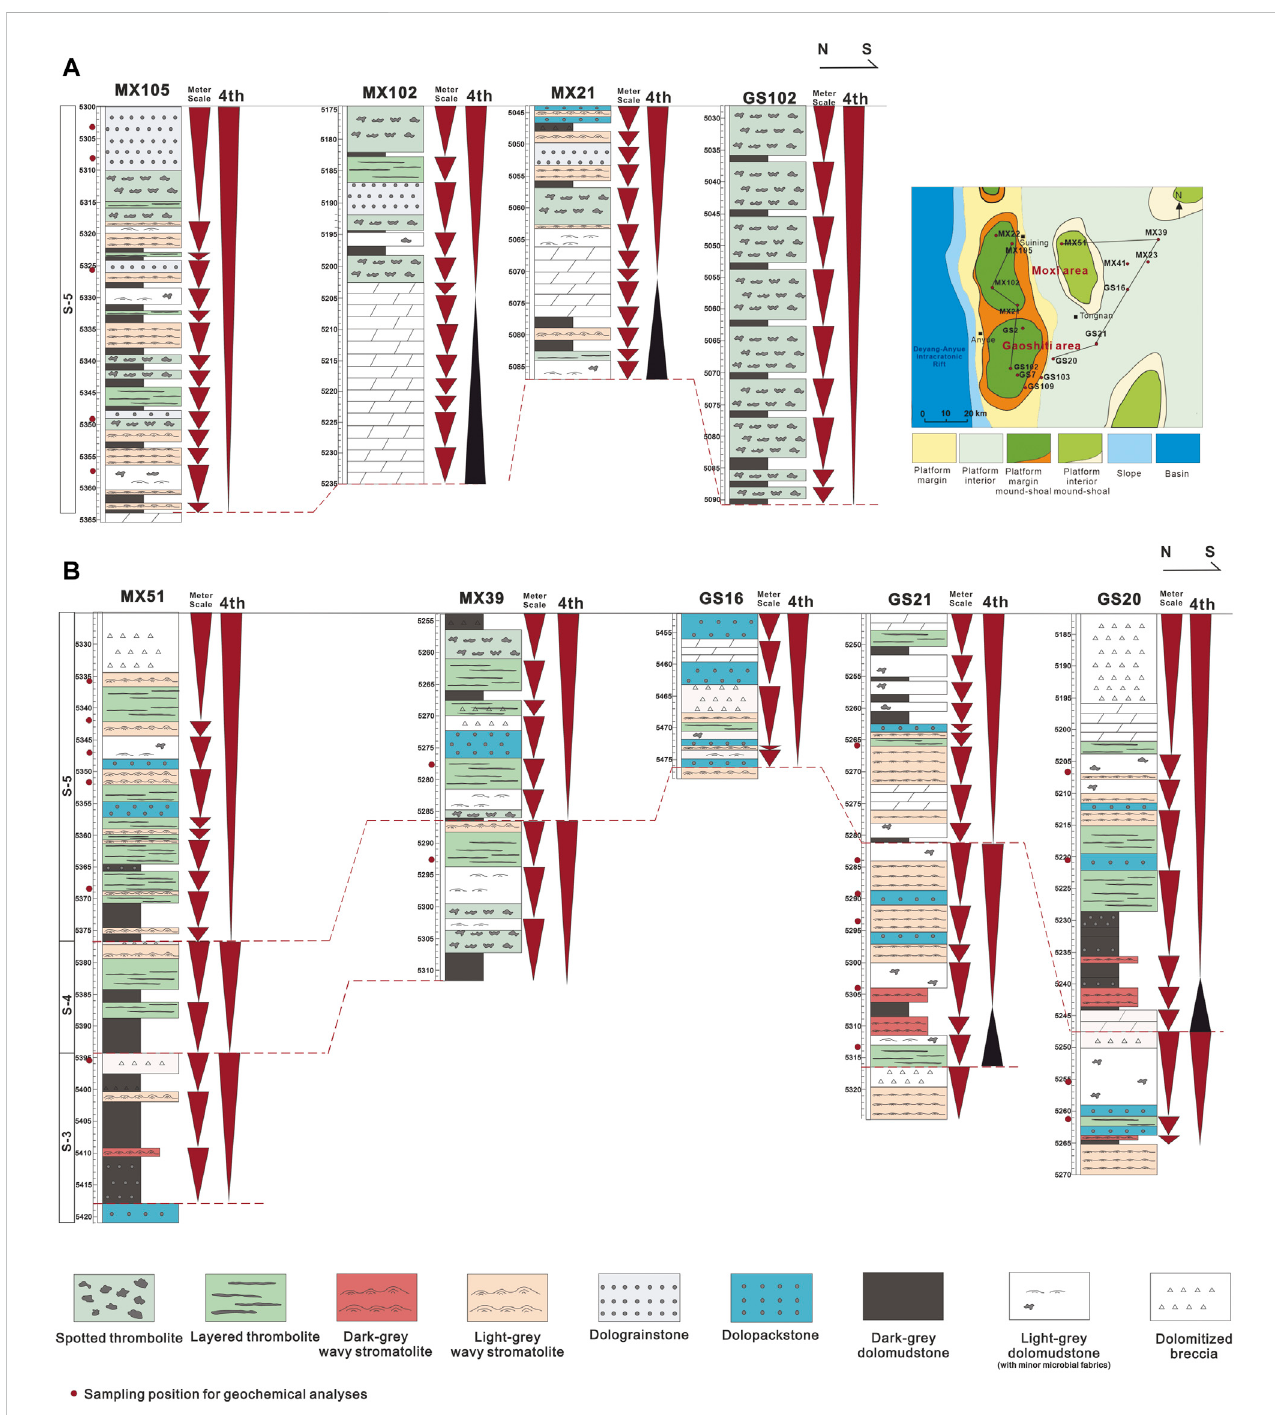
FIGURE 5 Detailed cores distribution in fourth-order sequence stratigraphic frameworks in the Gaoshiti - Moxi area. (A) Cores distribution in fourth-order sequence stratigrahpic frameworks in the platform margin. (B) Cores distribution in fourth-order sequence stratigrahpic frameworks in the platform interior.